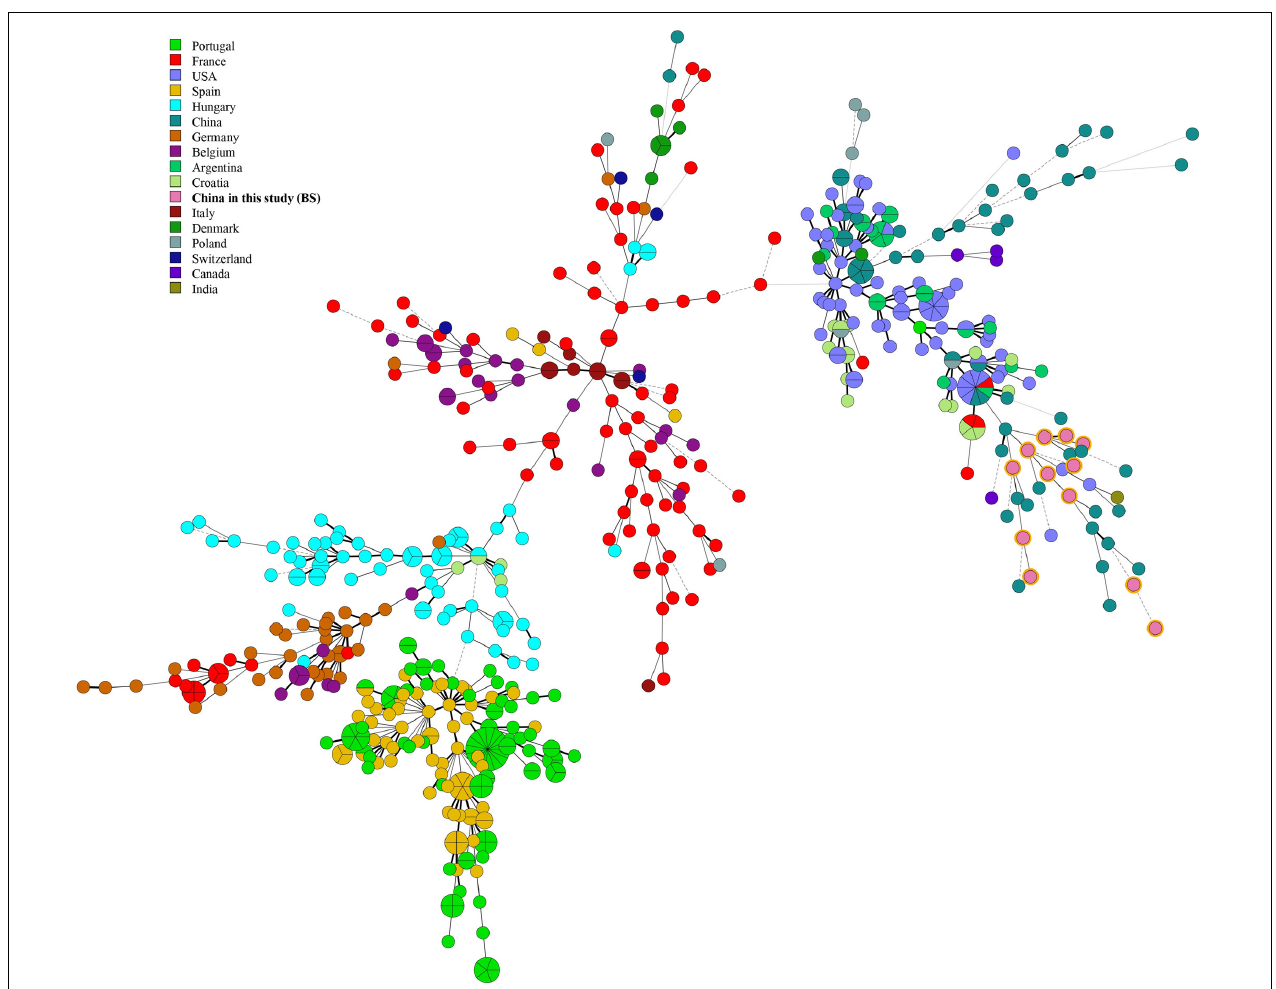
FIGURE 7 | Minimum Spanning Tree characteristics based on global B. suis